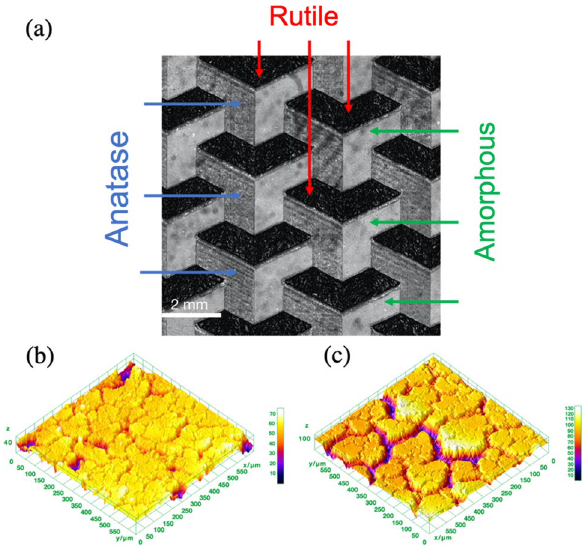
Figure 8. Complex laser crystallized TiO 2 polymorphic meta-structure. ( a ) Laser scanning microscopy image. (b,c) Typical high-resolution topographic 3D surface reconstructions of the ( b ) anatase and ( c ) rutile areas generated using the software ImageJ based on the data obtained with the laser scanning microscope